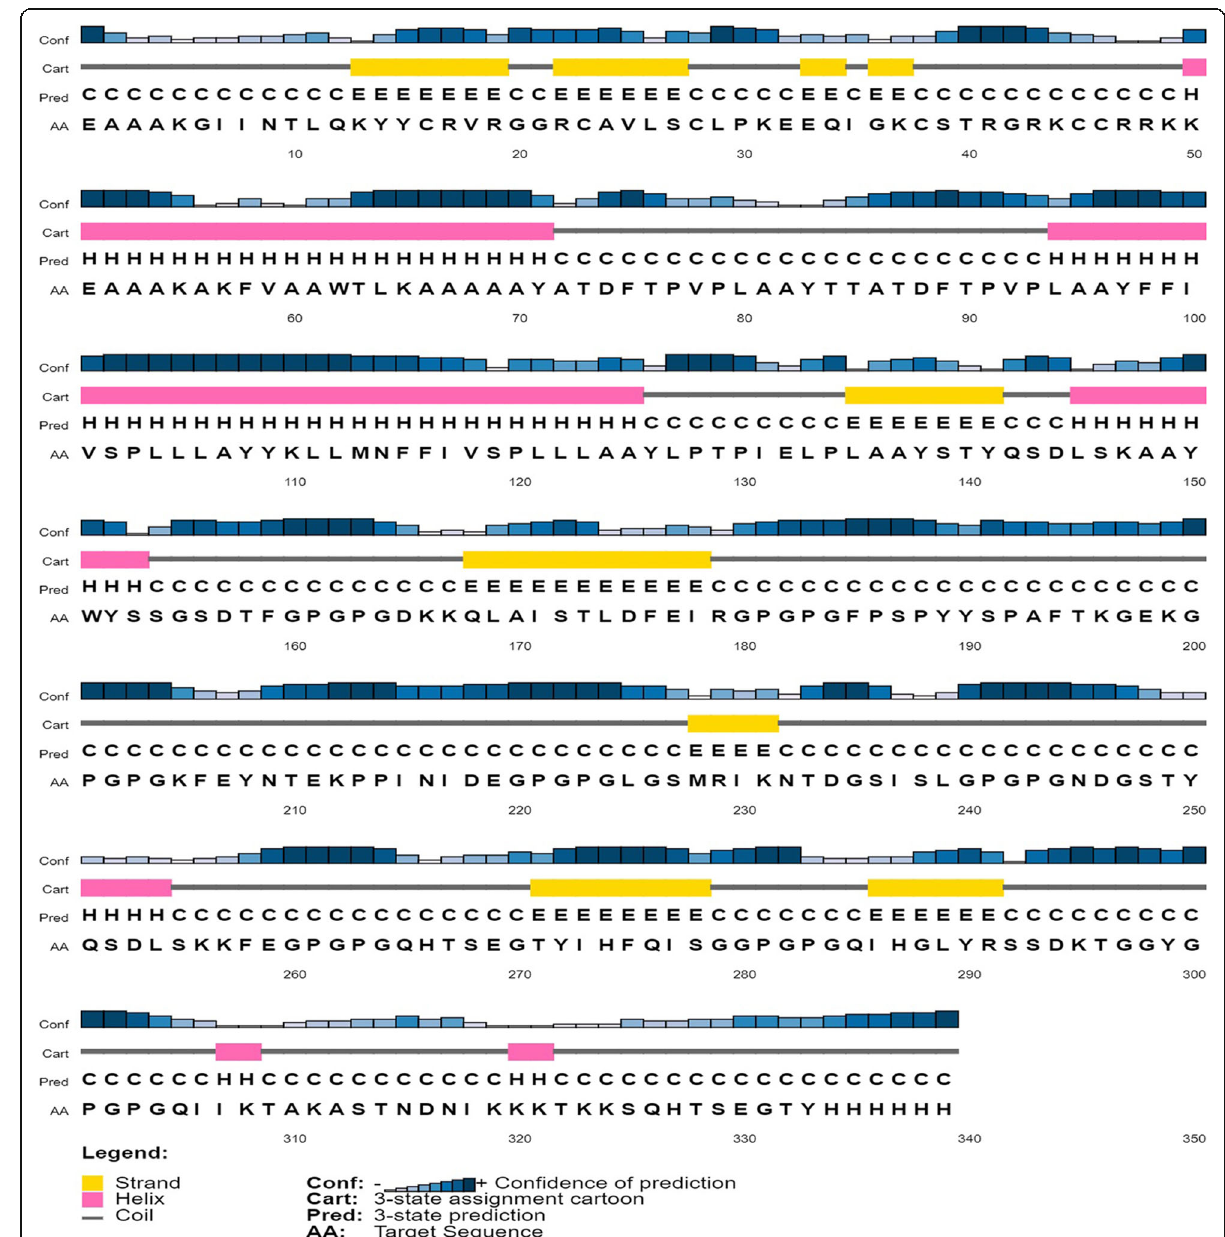
Fig. 4 Secondary structure of the vaccine protein constructed through PSIPRED